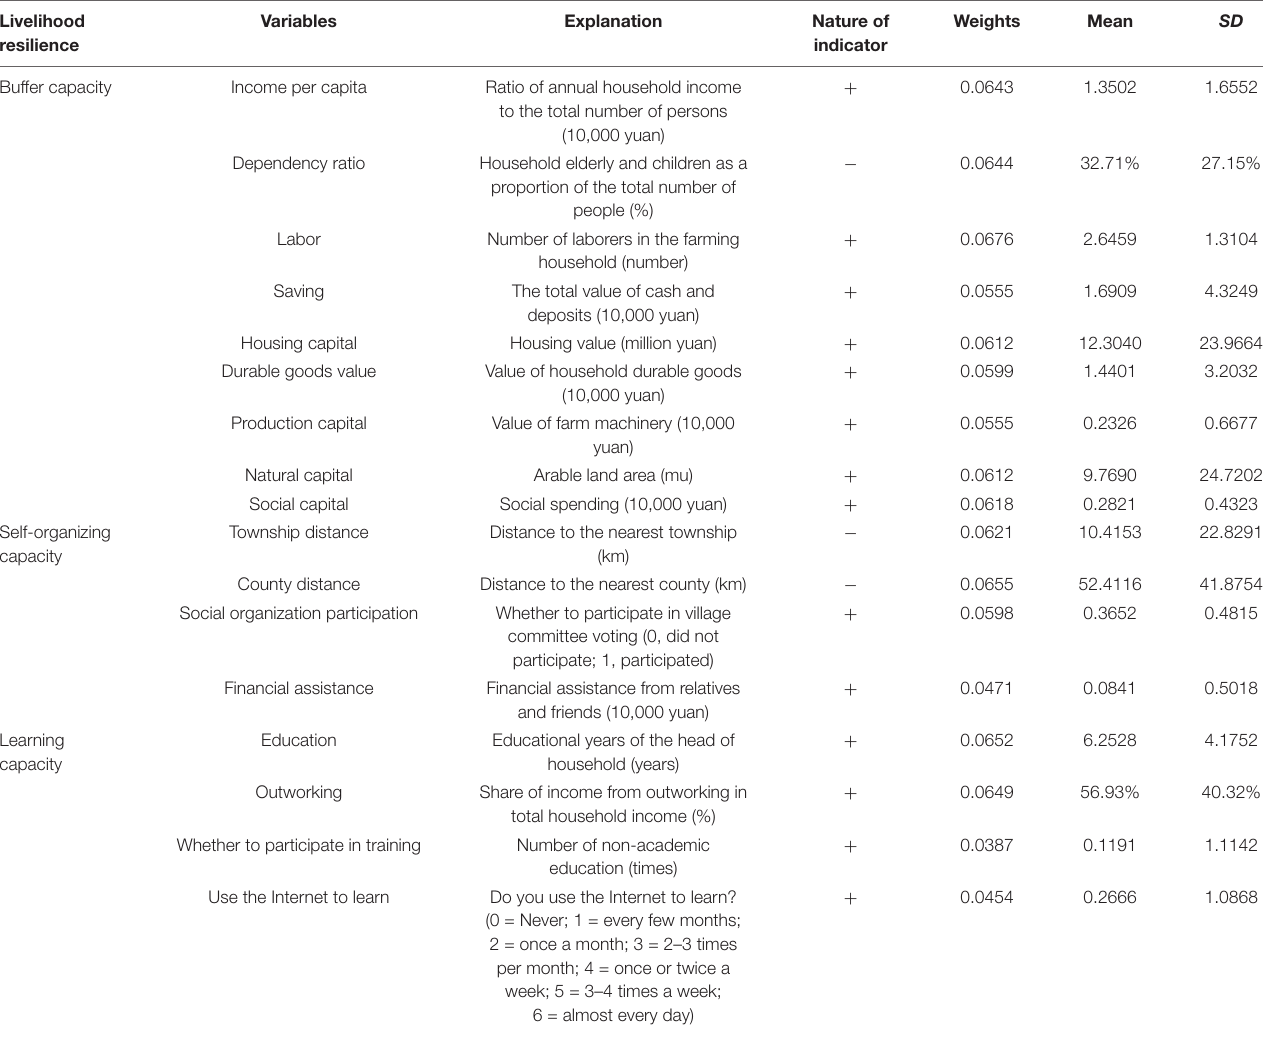
TABLE 1 | Indexes of the livelihood resilience of rural households for analysis. Livelihood